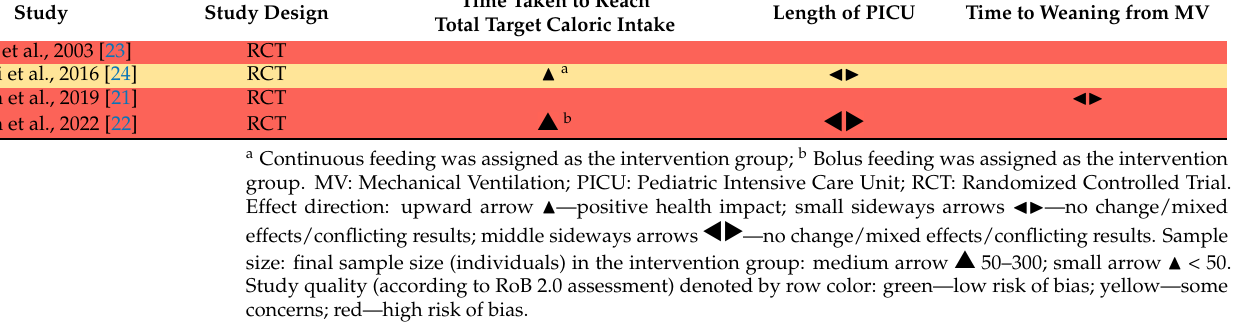
Table 3. Effect-direction plot of the outcomes of our interest.